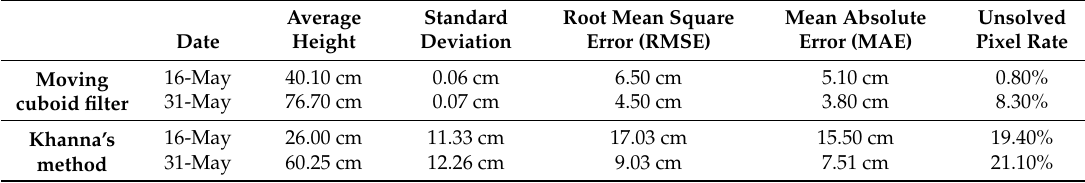
Table 3. Comparison of the performance of the moving cuboid filter and Khanna